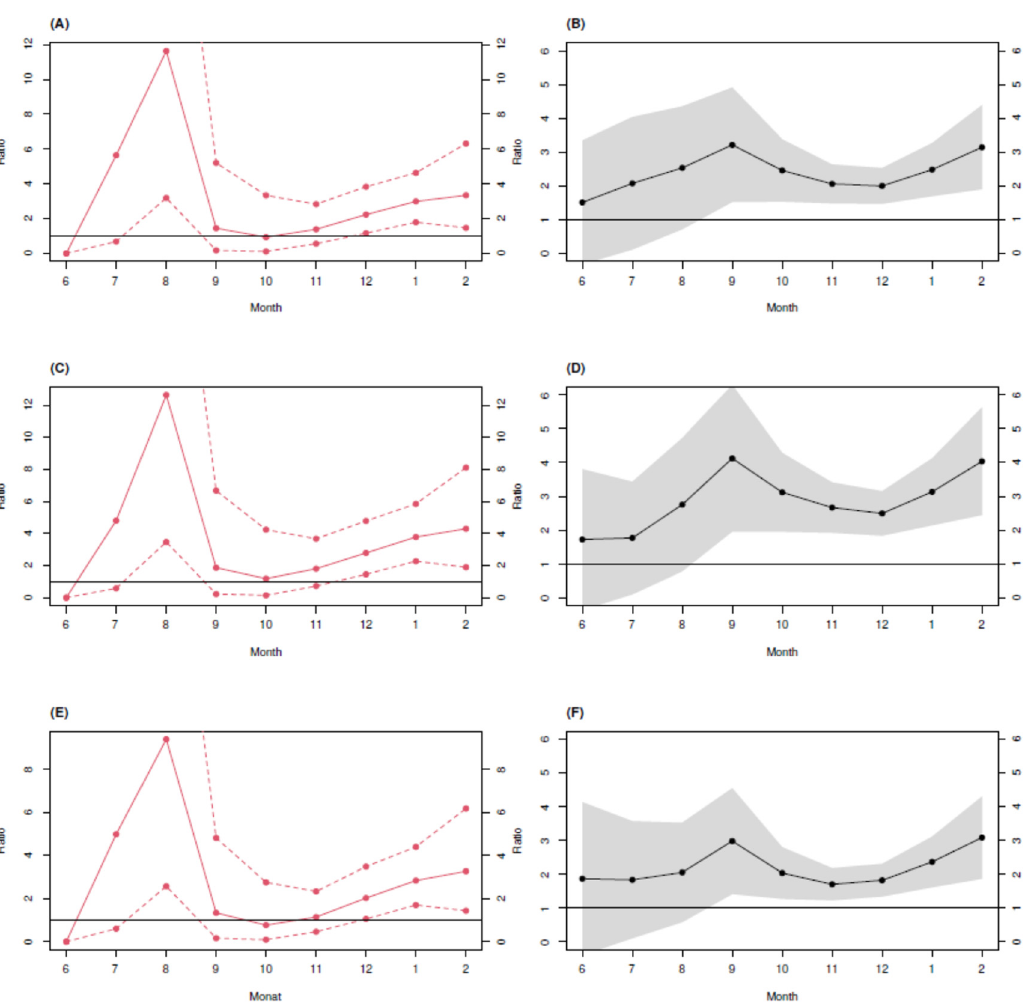
Figure 4. Ratio of observed seroprevalence from the Corkid study to the RKI-confirmed cumulative cases by time. RKI data [7] are age-standardized. Left column ( A , C , E ): ratio based on plain seroprevalence observations. Right column ( B , D , F ): ratio based on the fitted logistic curve. ( A , B ): Bochum. ( C , D ) Gütersloh. ( E , F ) Herne.